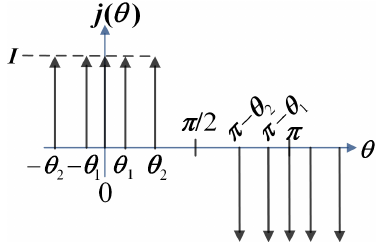
Figure 6. Representation of the space current density